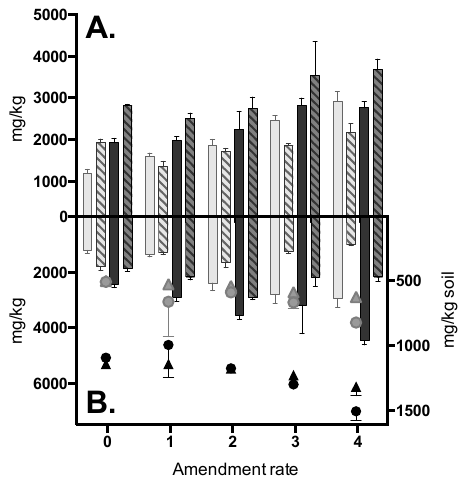
Figure 7. The phosphorus concentration of shoots ( A ) and roots ( B ) grown in Freeman (light grey) or Bernhill (dark grey) soils amended with KB- (solid) or wood- (cross- hatched) sourced biochars. The phosphorus of the soils (right axis, (B)) is also plotted for Freeman (light grey) or Bernhill (dark grey) soils amended with KB- (circle) or wood- (triangle) sourced biochars (Trippe 2015). Amendment rates are represented as 0–4, which correspond to rates of 0%, 3%, 6%, 16%, and 25% by volume for both biochars, 0%, 0.7%, 1.7%, 3.7%, and 8.6% by mass for wood biochar, and 0%, 0.4%, 1.2%, 2.5%, and 5.8% by mass for KB-sourced biochar.